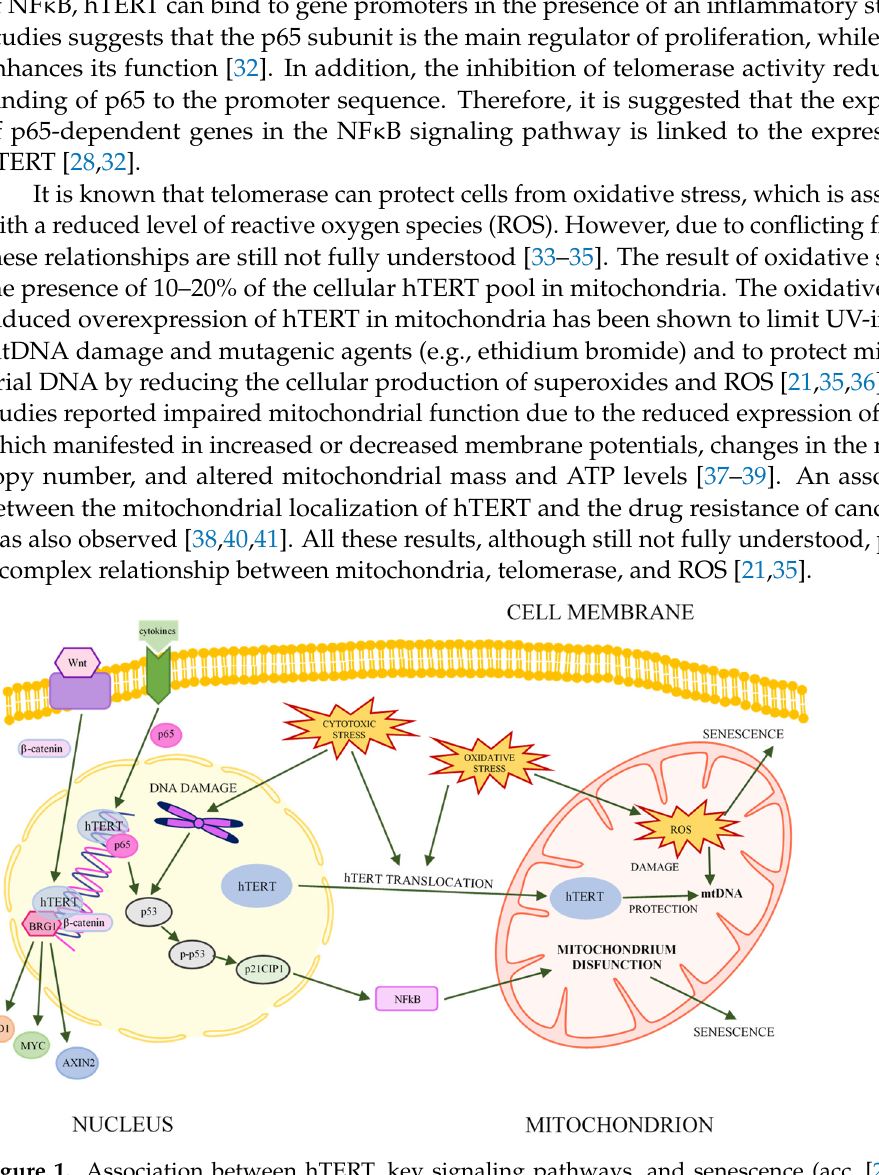
Figure 1. Association between hTERT, key signaling pathways, and senescence (acc. [21,22,39], modified). The hTERT subunit of telomerase can be involved in various metabolic pathways (e.g., NF κ B, Wnt/ β -catenin, and adhesion as well as senescence) and affect the expression of various genes. Under the influence of stress, hTERT is translocated to mitochondria, where hTERT protects mitochondrial metabolism by lowering the level of ROS and binding to mtDNA.